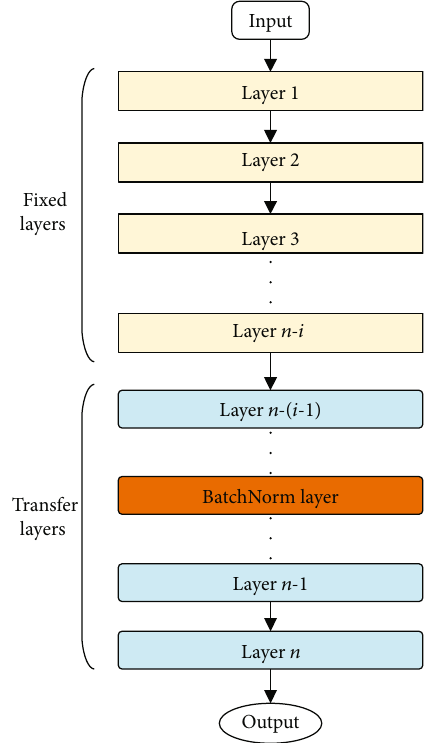
Figure 4: The structure of DTL using the AdaBN